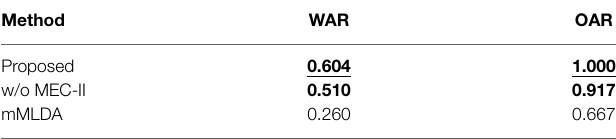
TABLE 2 | Results of evaluation values for the action generation using the results of the CSL for 40 trials (ROW is 0%).